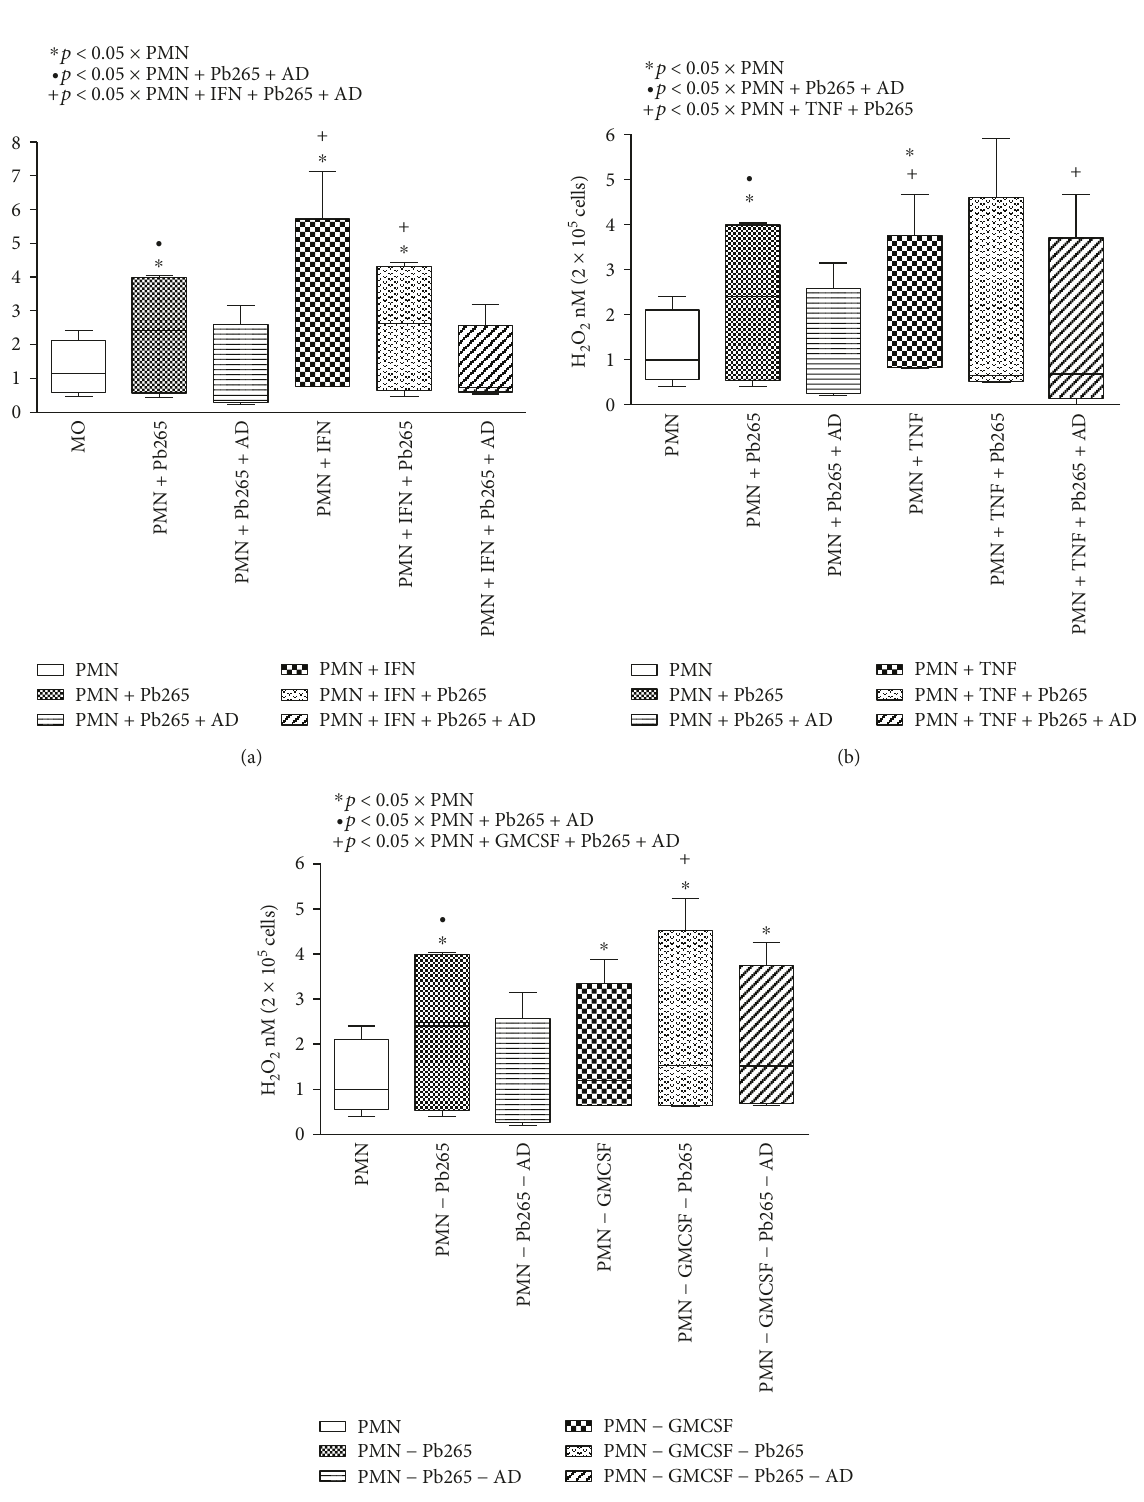
Figure 6: Hydrogen peroxide (H O ) production by neutrophils (PMN) treated or not with IFN- γ (a), TNF- α (b), and GM-CSF (c) for 18 2 2 hours in the presence or absence of the anti-Dectin-1 monoclonal antibody (AD) and challenged or not with Pb265 for 4 hours. Box-and-whisker plot showing data distribution of 8 healthy volunteer donors. Statistical signi fi cance between groups is